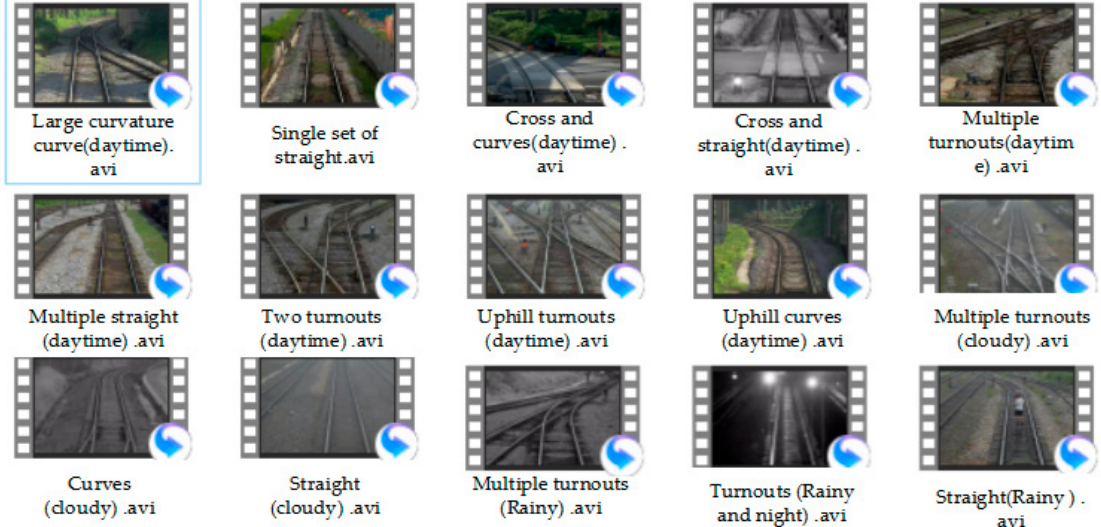
Figure 18. Driving routes under different lighting conditions and directions.